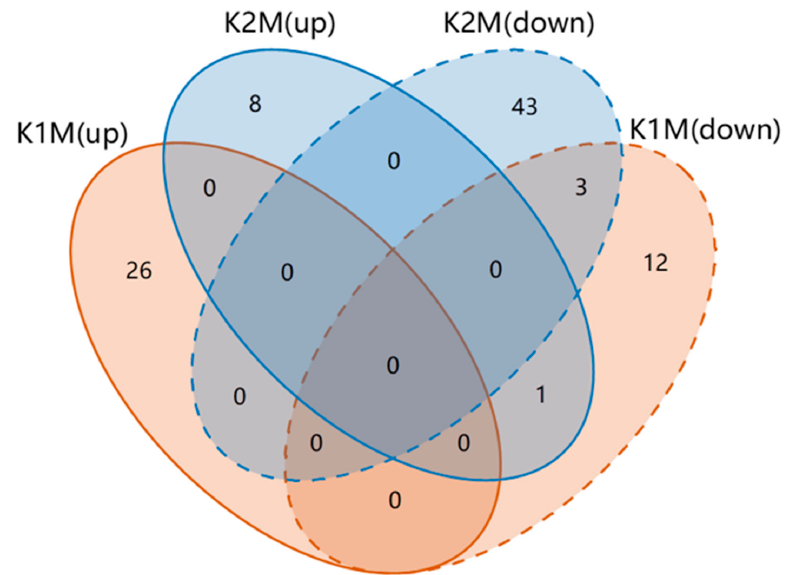
Figure 5. Venn diagram of all differential metabolites from the experimental groups (K1M and K2M) both in positive and negative ion mode. Circles in orange indicate the AjK1 treatment group; circles in blue indicate the AjK2 treatment group; solid lines mean that metabolites are up-regulated; dashed lines mean that they are down-regulated.